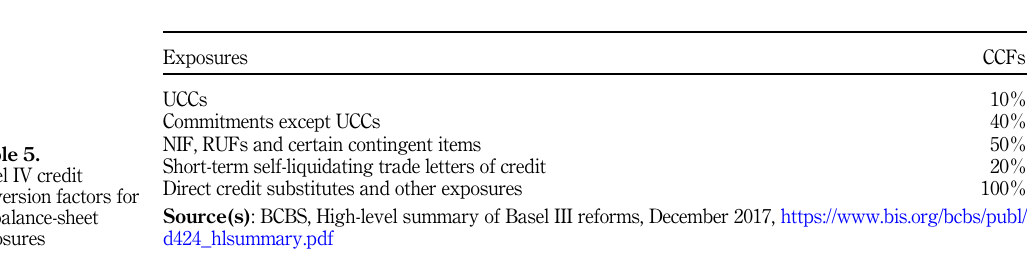
Table 5. Basel IV credit conversion factors for off-balance-sheet